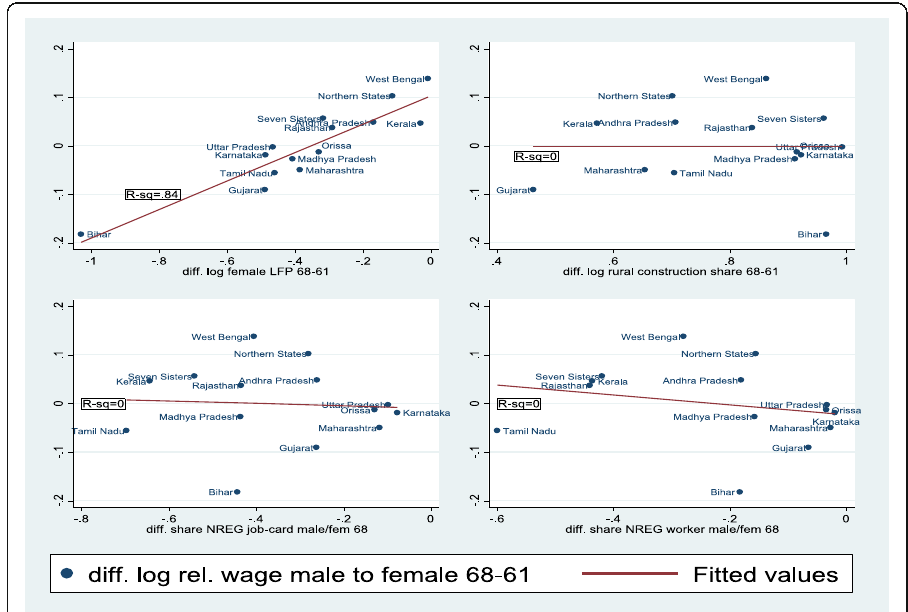
Fig. 14 Drivers of changes in male vs. female wages within rural